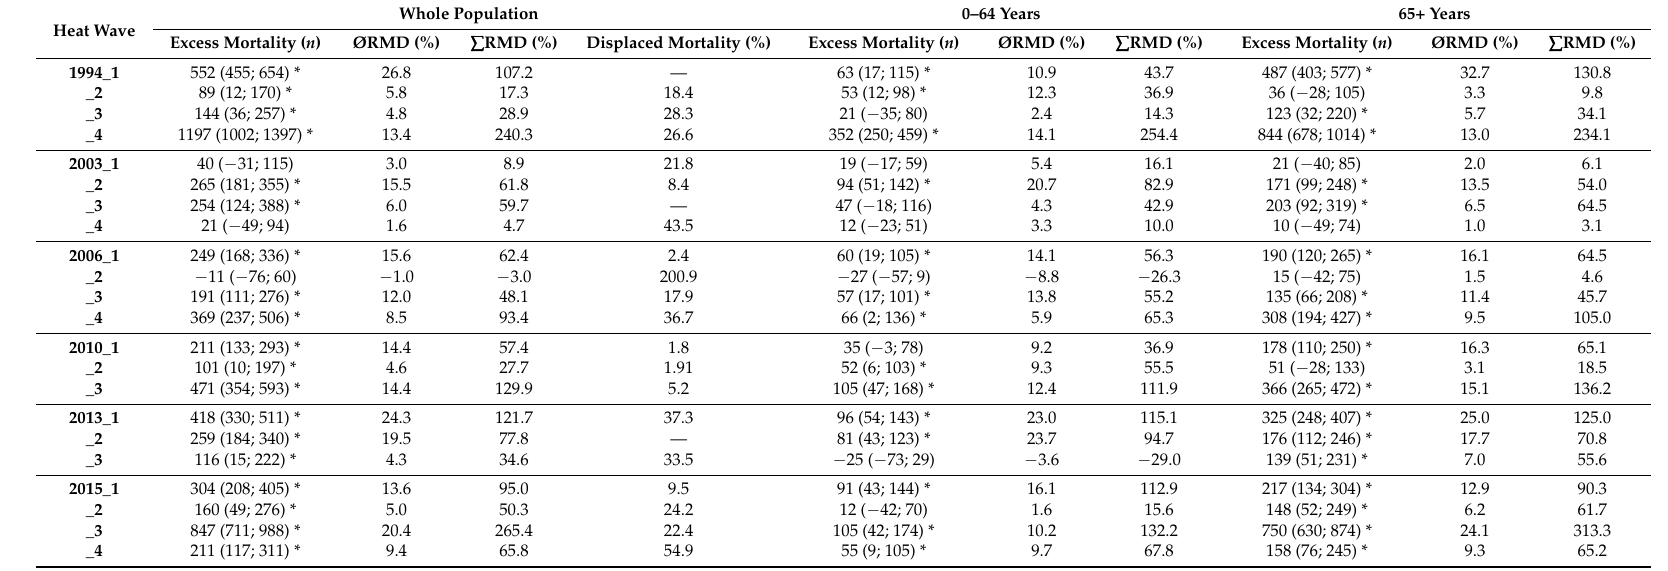
Table 2. Impact of heat waves on mortality for the whole population, and the younger (0–64 years) and the elderly (65+ years) age groups, within six years with the longest total heat-wave duration during 1994–2015. The variables represent sum of excess deaths per standardized 10,000,000 inhabitants (excess mortality) and its 95% confidence intervals (CI), mean relative mortality deviation (ØRMD), and cumulative relative mortality deviation ( ∑ RMD) during heat waves. Displaced mortality represents the absolute value of the ratio of the sum of three-day-averaged mortality deviations during the negative phase of the extended heat wave period (EHP) to the sum of three-day-averaged mortality deviations during the positive phase (see Section 2.5.3). — indicates that the heat wave was considered as a single EHP together with the following one. * denotes statistically significant excess